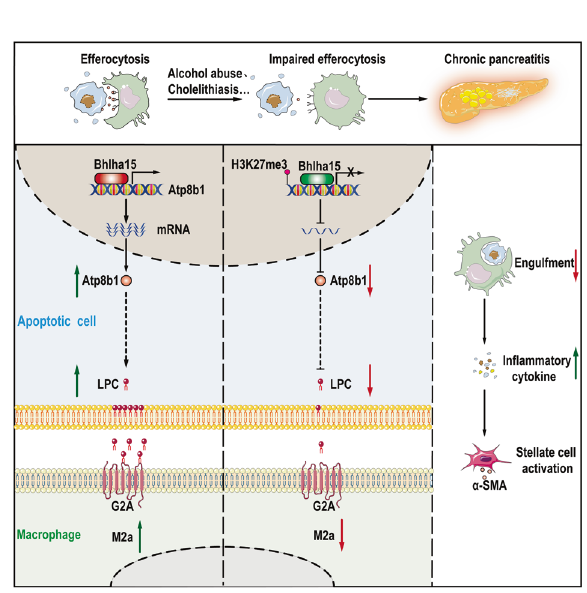
Fig. 7 Graphical abstract. Mechanistic diagram showing how efferocytosis effect CP process through regulating Bhlha15/ Atp8b1/LPC pathway to alter the regulation of phospholipid metabolism. Under normal conditions on the left, macrophages engulf apoptotic acinar cells through efferocytosis to resolve in fl ammation. Alcohol abuse and cholelithiasis can injury